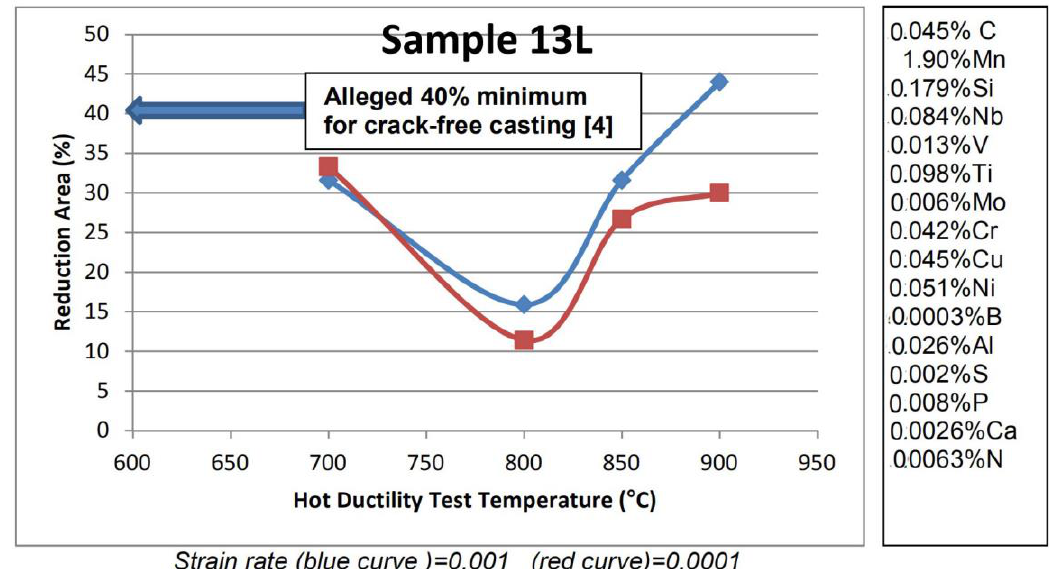
Figure 3. Percent Reduction in Area Hot Ductility Test [12].